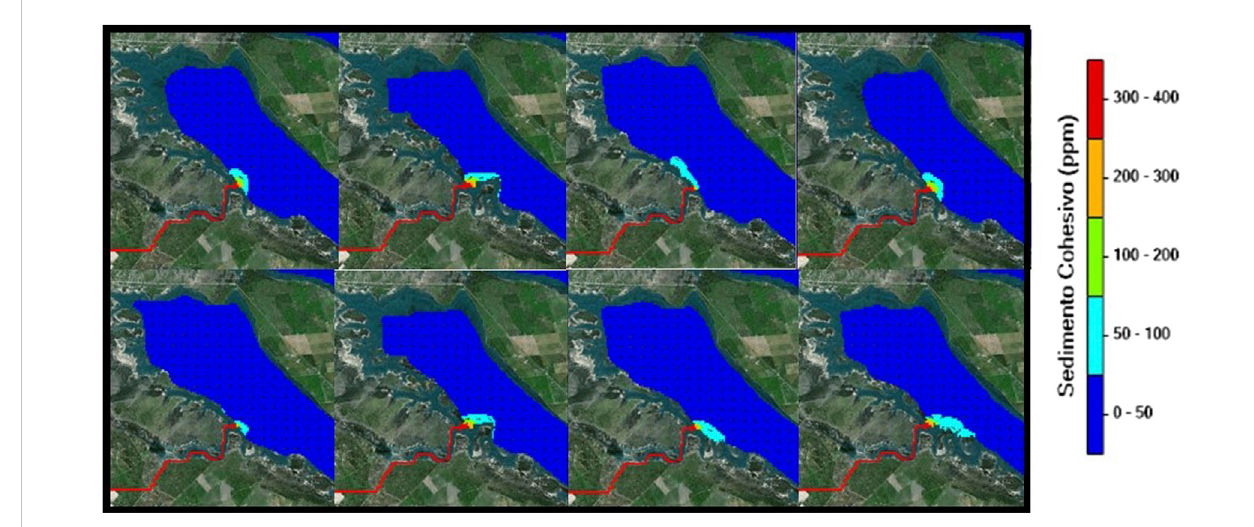
CS discharges of Irrigation network over the sea- 2019/01/03 (00 – 21 h).